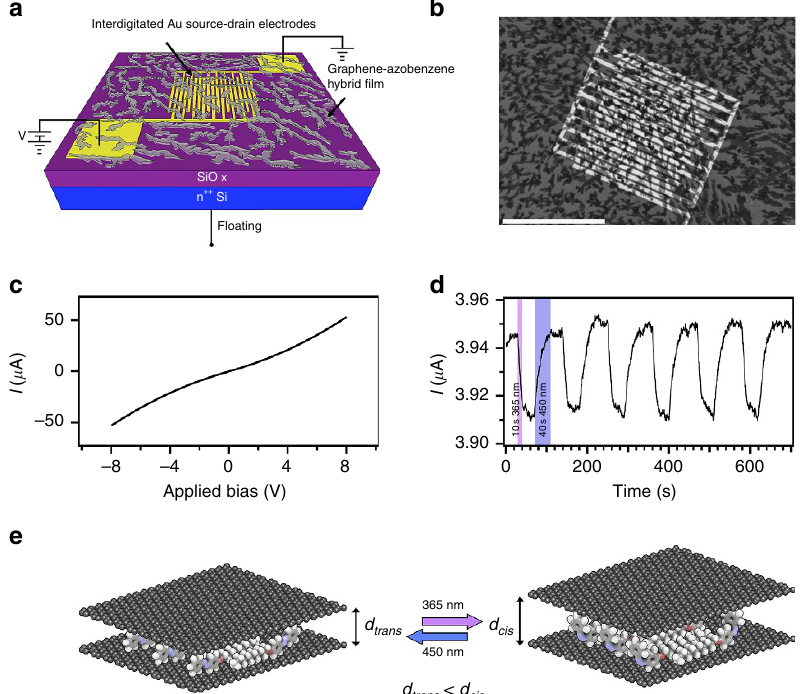
Figure 5 | Electrical characteristics of hybrid materials. ( a ) Scheme of the two-terminal device configuration, ( b ) scanning electron microscopy image of interdigitated Au electrodes covered with a hybrid film. Scale bar, 500 m m. ( c ) I – V characteristics, ( d ) optical modulation of current response for a static bias and dynamic alternative UV and visible light irradiation cycles. ( e ) Schematic of graphene-azobenzene hybrid undergoing UV and visible irradiation